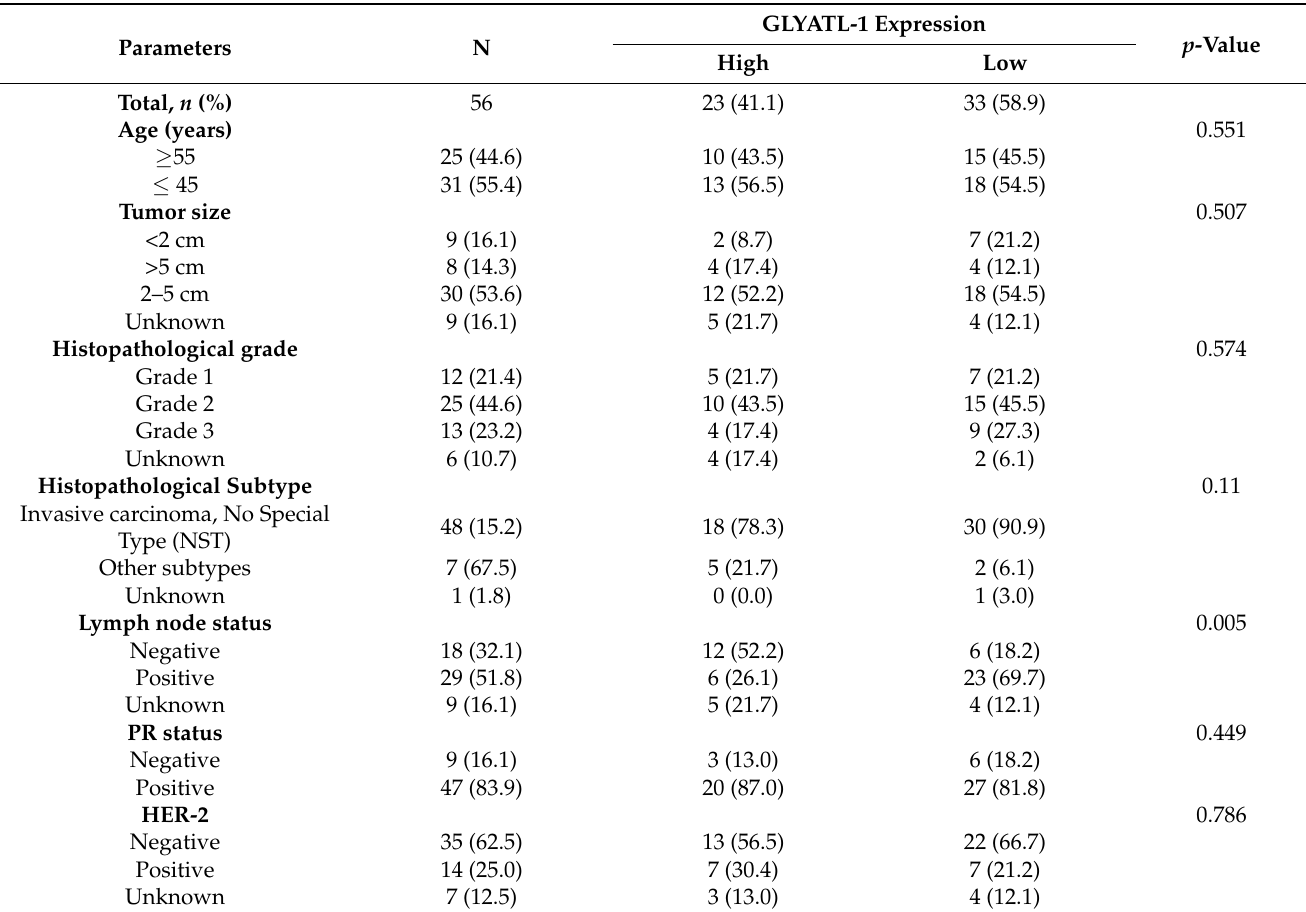
Table 6. Association between GLYATL-1 expression and the clinicopathological features of breast cancer